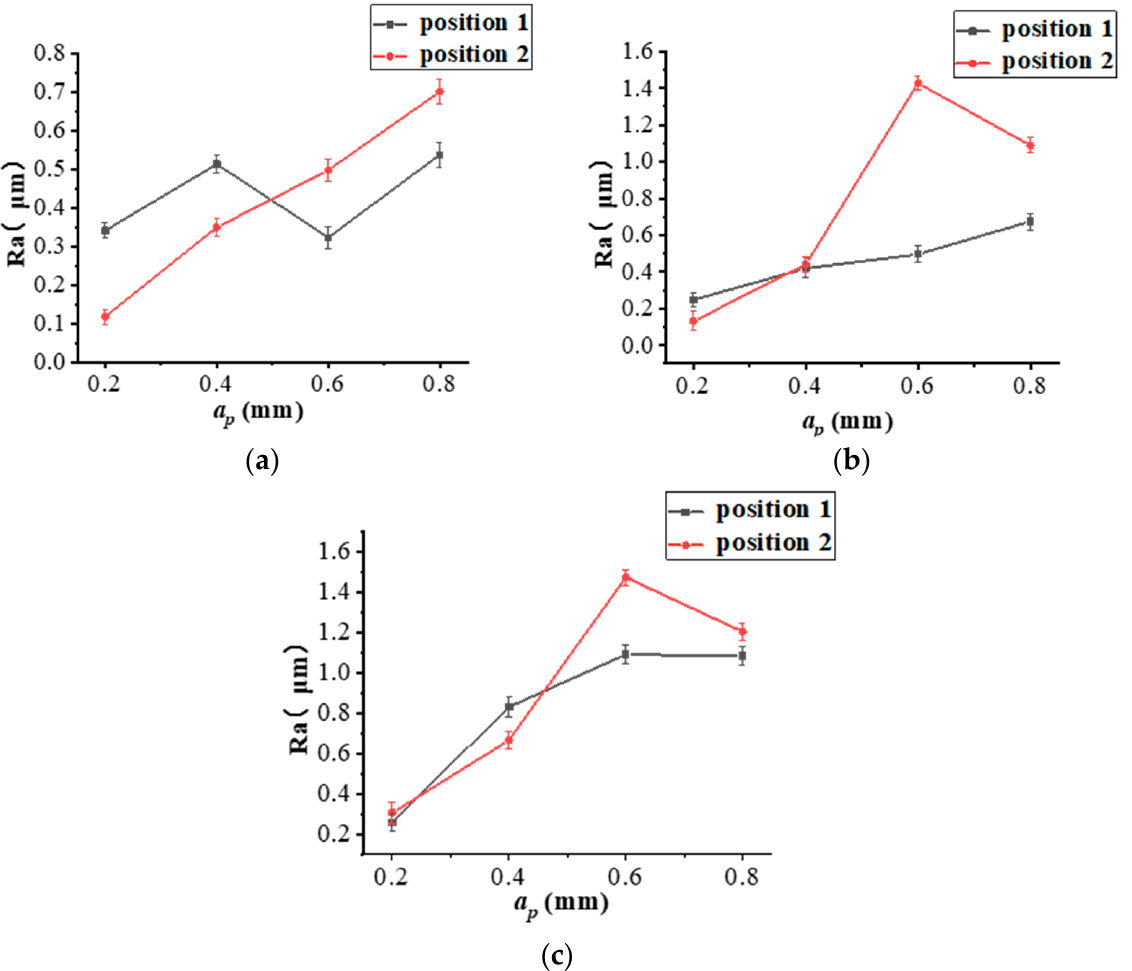
Figure 15. Surface roughness comparison of Position 1 and Position 2 at different spindle speeds. ( a ) n = 1000 r/min; ( b ) n = 2000 r/min; and ( c ) n = 3000 r/min.